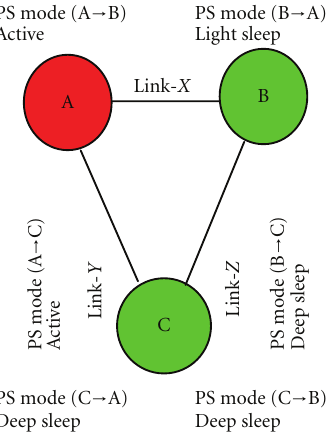
Figure 1: Link specific power modes of three mesh STAs. STA A is in active mode. STAs B and C are in